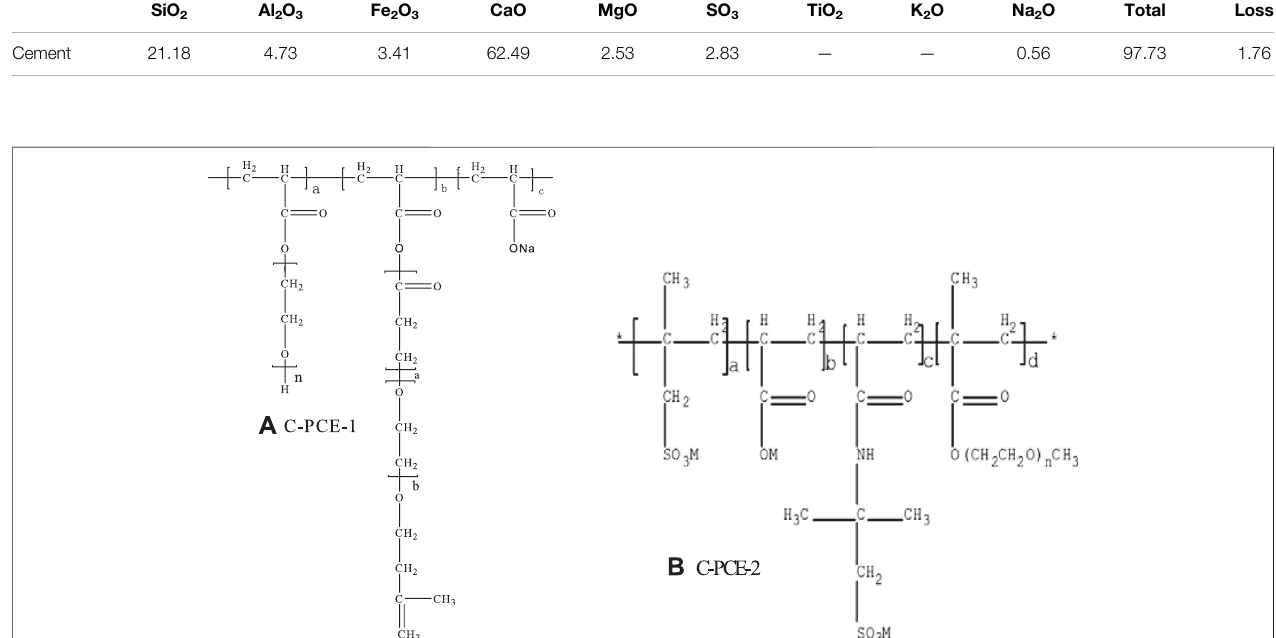
FIGURE 1 | Chemical structure of commercial polycarboxylate (C-PCE-1 and